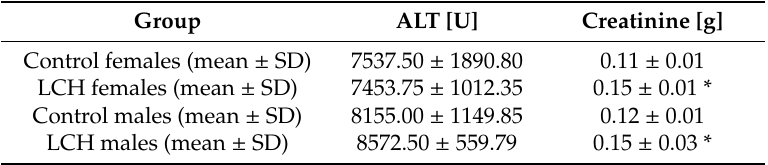
Table 5. Alanine transaminase (ALT) activity and creatinine concentration.